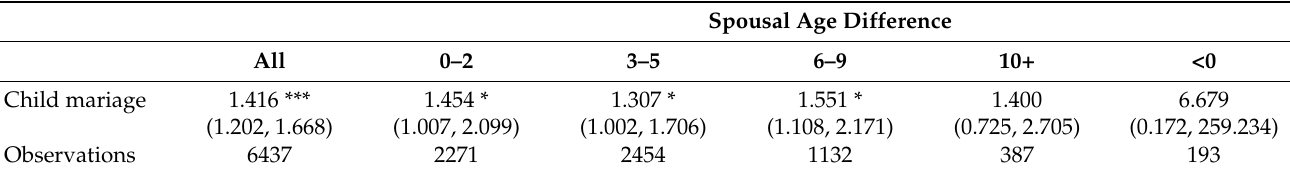
Table 7. Odds ratios in favor being obese by spousal age-difference groups.